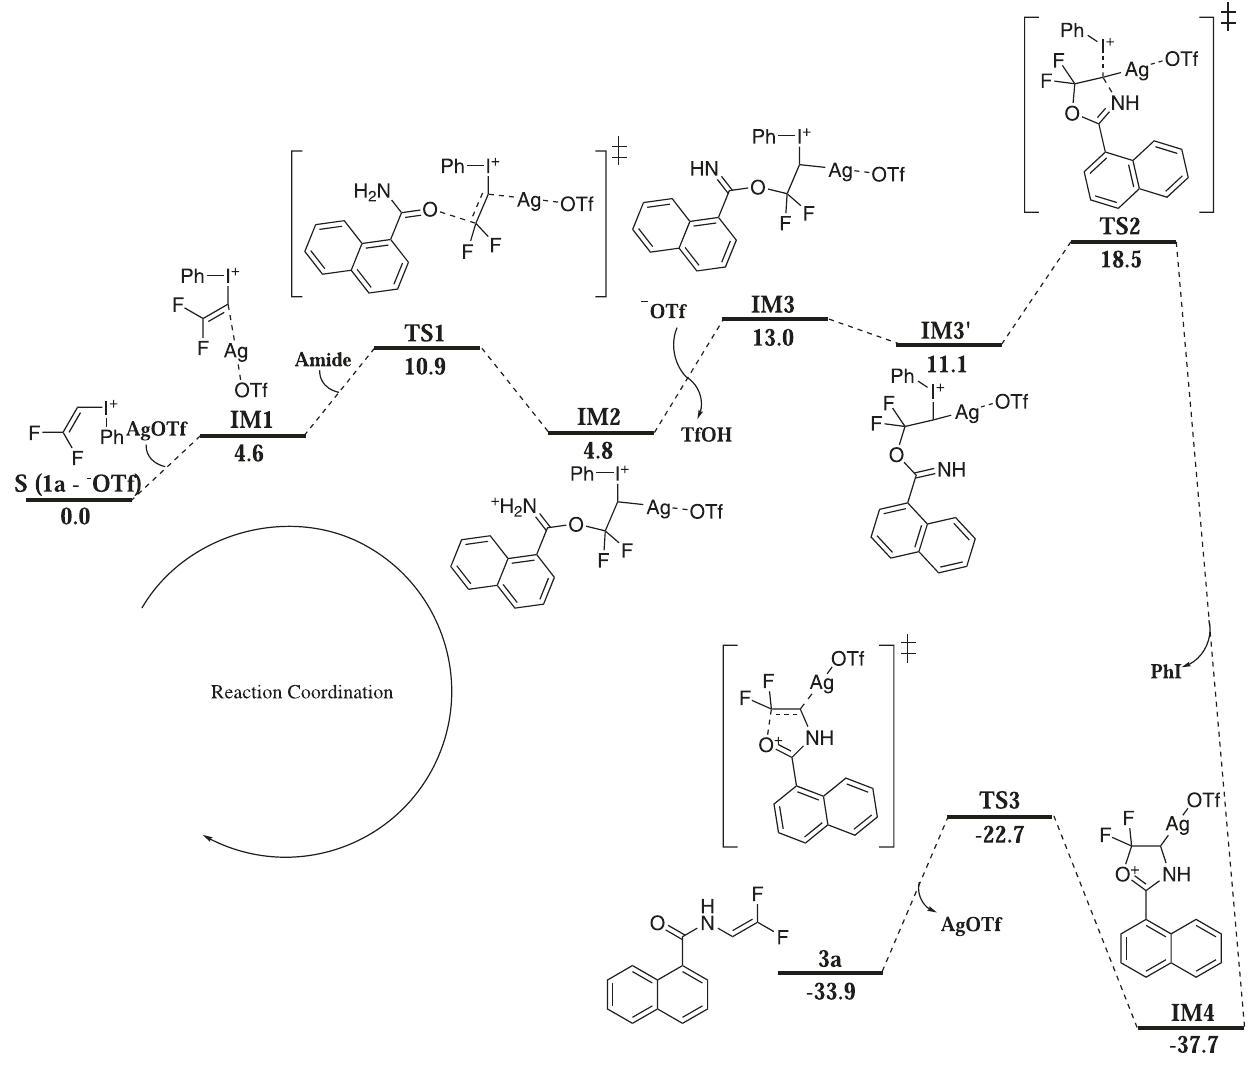
Fig. 8 Computed Gibbs free energy pro fi le of the gem-di fl uorovinylation of amide. The energies are given in kcal/mol.